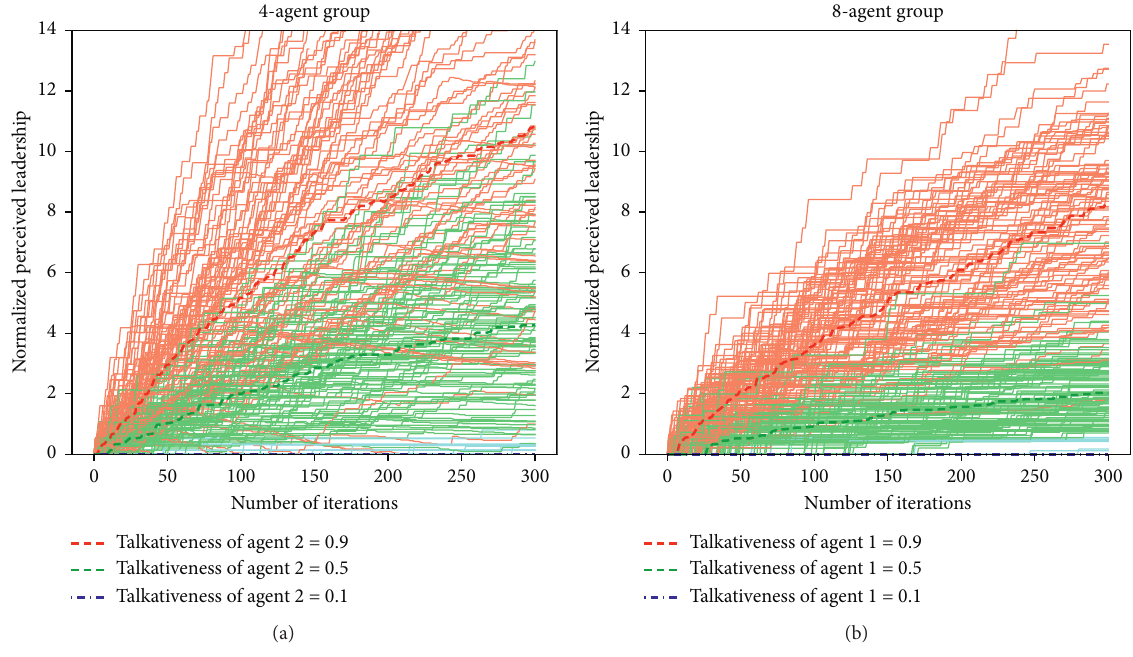
Figure 5: Perceived leadership of a certain agent (leader) with 3 levels of talkativeness in 4-agent group (a) and 8-agent group (b). The thin lines show the results of 100 independent simulation runs, while the thick dotted lines represent the median of those 100 runs. Note that agents’ other attributes are defined in Tables 1 and The bottom panels of Figure 3 show the change of trajectory (left) and utility (right) of the group plan. The group plan changes drastically with group planning itera- tions. It could repeat going back and forth between multiple points, which can be seen as the dark blue part in the bottom left panel of Figure 3. In the 4-agent group, the group plan tends to be stable after no more than 100 iterations, which